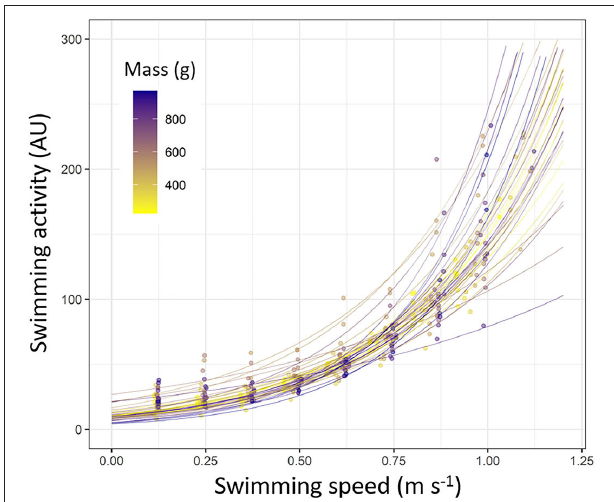
FIGURE 5 | Swimming activity (arbitrary unit, AU) measured by accelerometers tags depending on the swimming speed during U crit trial (m s − 1 ) in European sea bass ( Dicentrarchus labrax ; n = 40). Each line represents a fish based on exponential model ( y = α * e β *x ; statistics details about α and β for each fish are shown in Supplementary Table S5 ). Each dot represents a value obtained during U crit trial. Dots and line color are referring to the fish mass (from 200 to 1,000g; from yellow to dark blue).